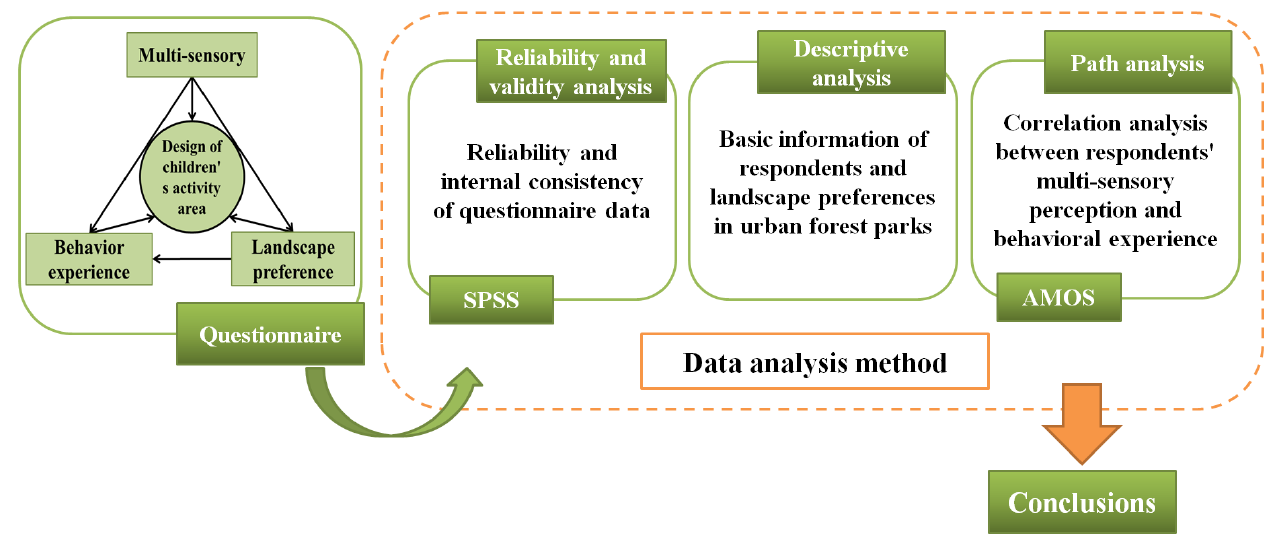
Figure 2. Research framework. Table 1. Reliability and validity